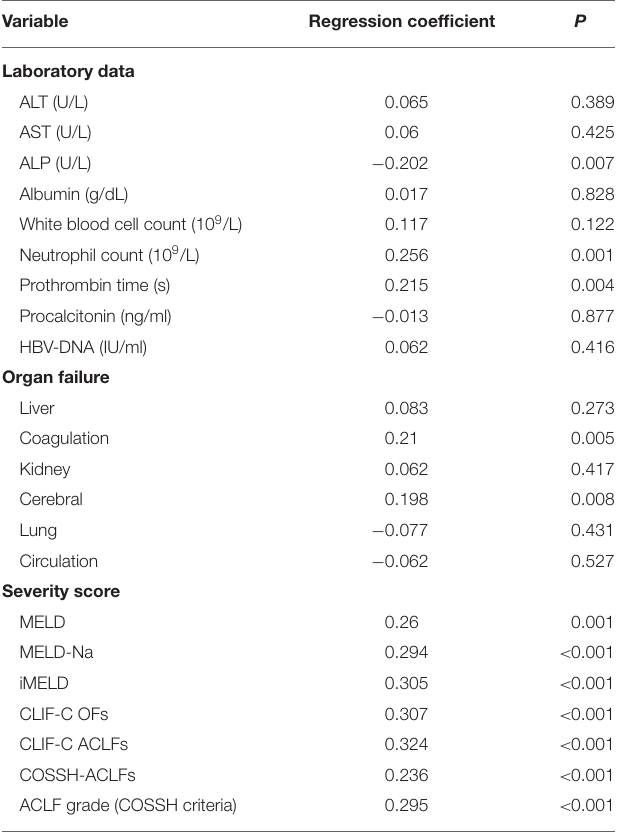
TABLE 3 | Univariate and multivariate logistic regression analysis investigating independent risk factors on 28-day survival for patients with HBV-ACLF.